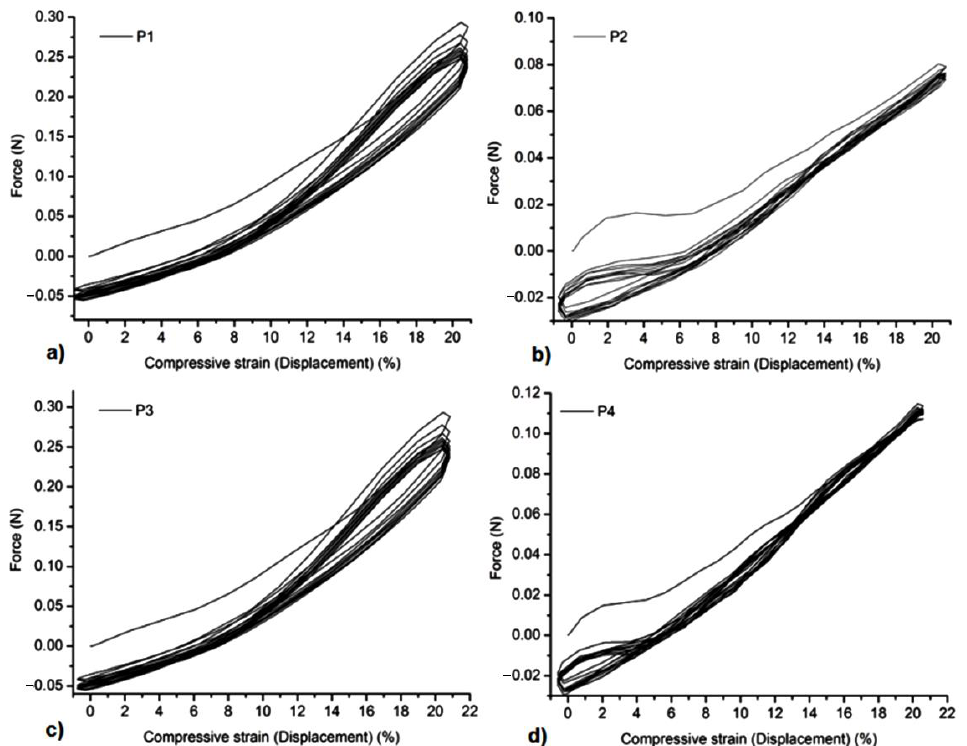
Figure 8. The dependence of Force/compressive strain % of the samples: a ) — P1, b ) — P2, c ) — P3, and d ) — P4.